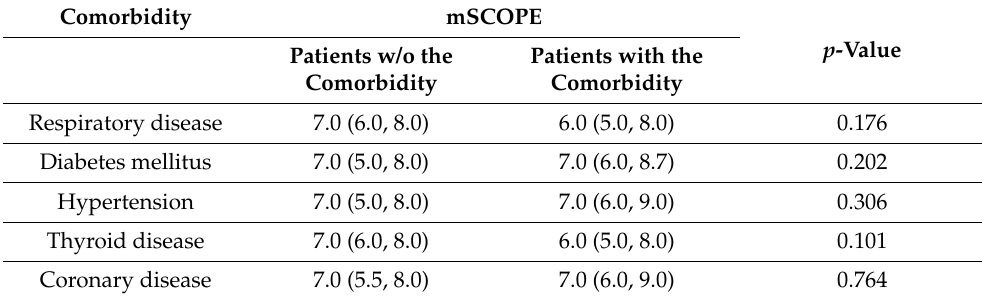
Table 3. Differences in mSCOPE scores among patients with and without significant